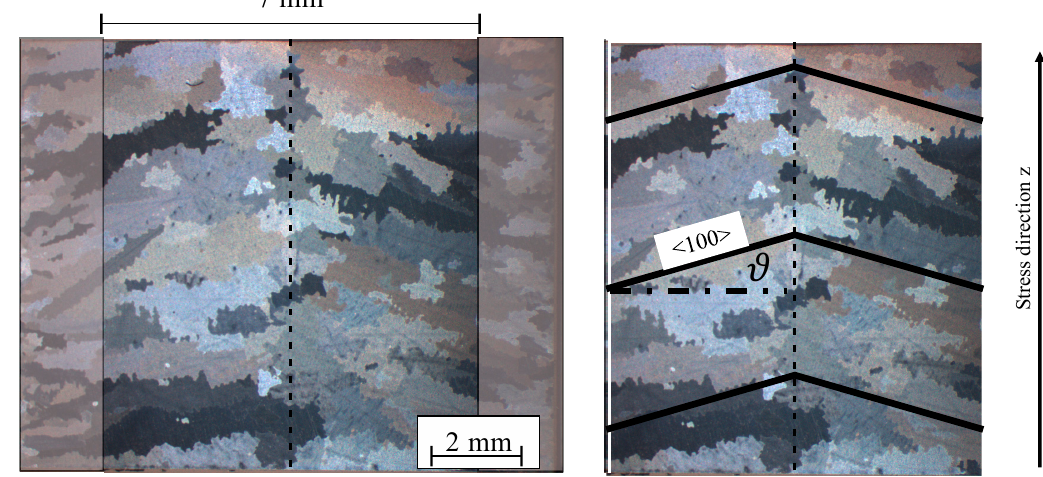
Figure 5. Light microscopy image of the vertical cross section of a 12 mm bar of Ren é 80. A preferential orientation of the grains was likely caused by the temperature gradients in the mold during solidification.